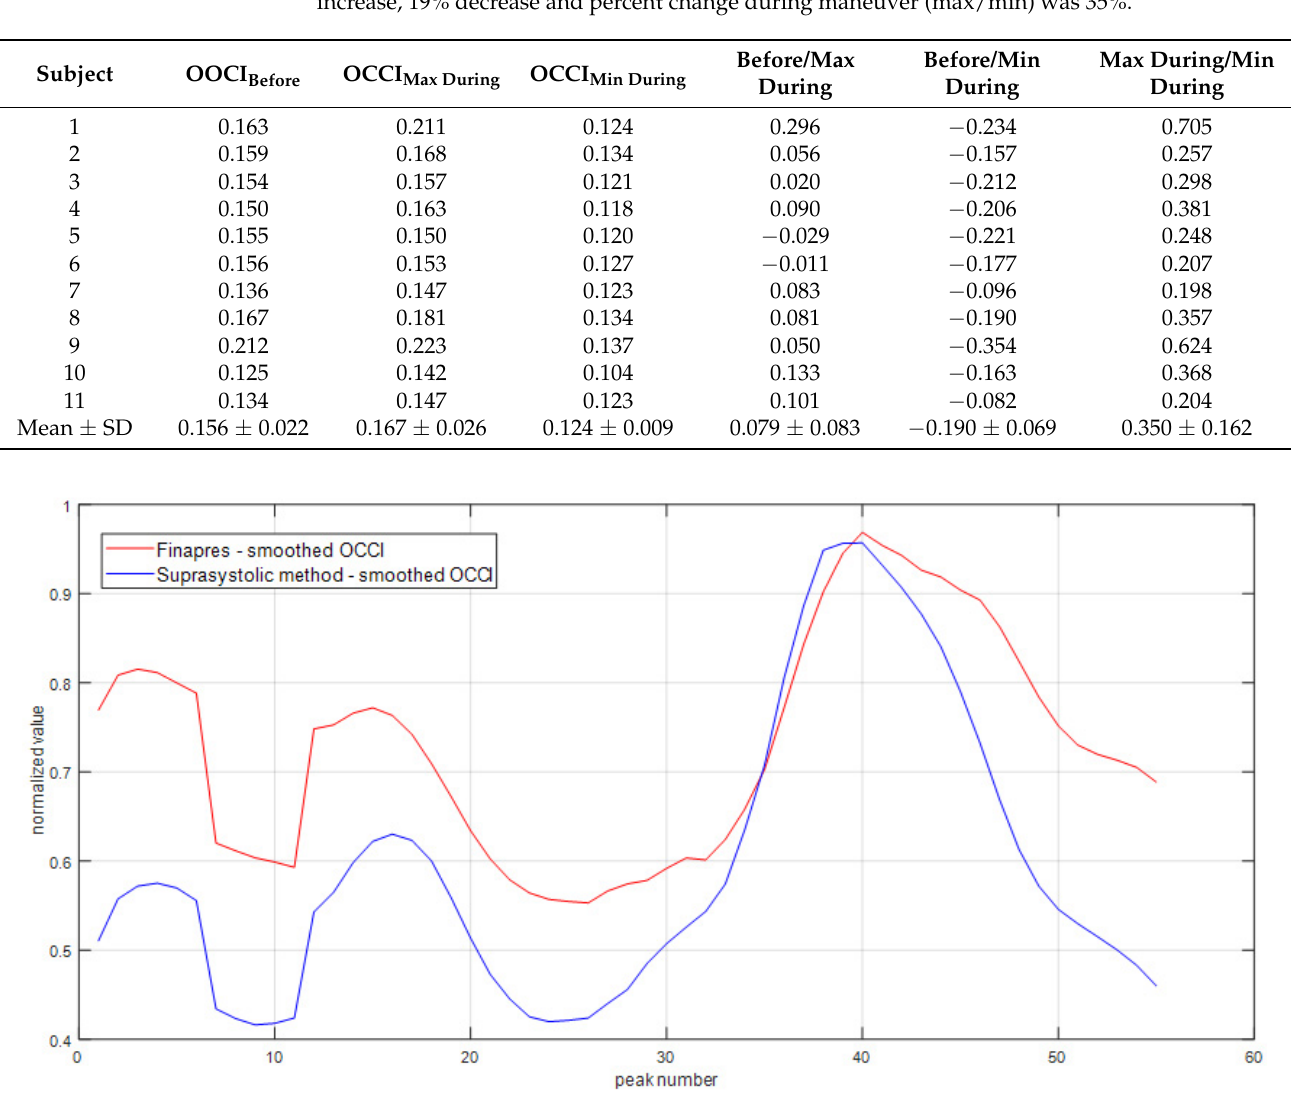
Figure 4. The example of OCCI calculation for the signals in Figure 2. The results were smoothed with smoothing filter to suppress the deviations and show the trend which OCCI has for better graphical impact. After the 14th peak started the maneuver and ended after 29th.